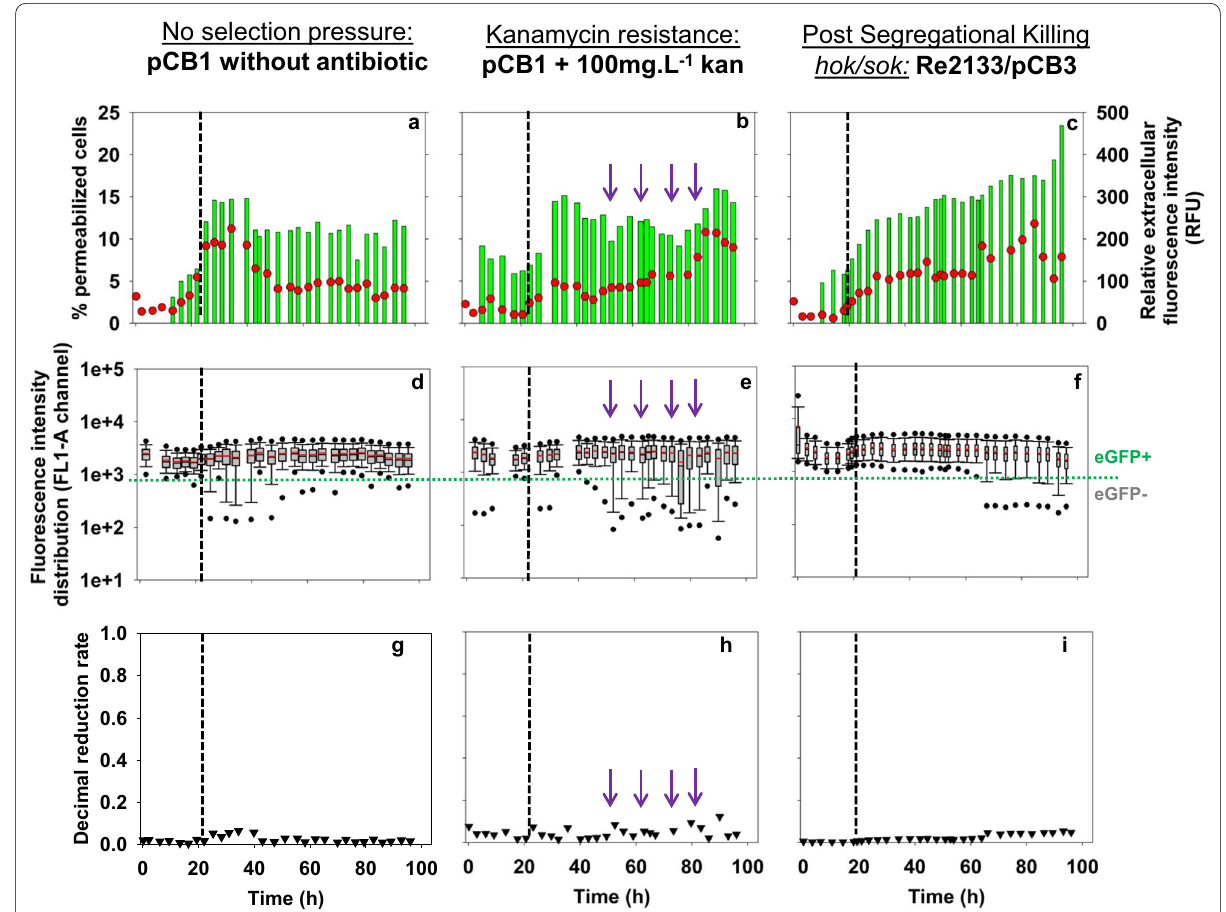
Fig. 5 Relative extracellular fluorescence intensity (FU/OD) ( ) and percentage of permeabilized cells ( ) in the FL3-A channel for Re2133/pCB1 without ( a ) and with ( b ) kanamycin and pCB3 ( c ). Boxplot comparison on fluorescence intensity distribution in the FL1-A channel for Re2133/pCB1 without ( d ) and with ( e ) kanamycin and pCB3 ( f ). Evolution of the decimal reduction rate N ( ▼ ) during pCB1 without ( g ) and with ( h ) kanamycin and pCB3 ( i ). Black horizontal lines represent the beginning of the fed-batch phase. Ppurple arrows represent additions (kanamycin, 100